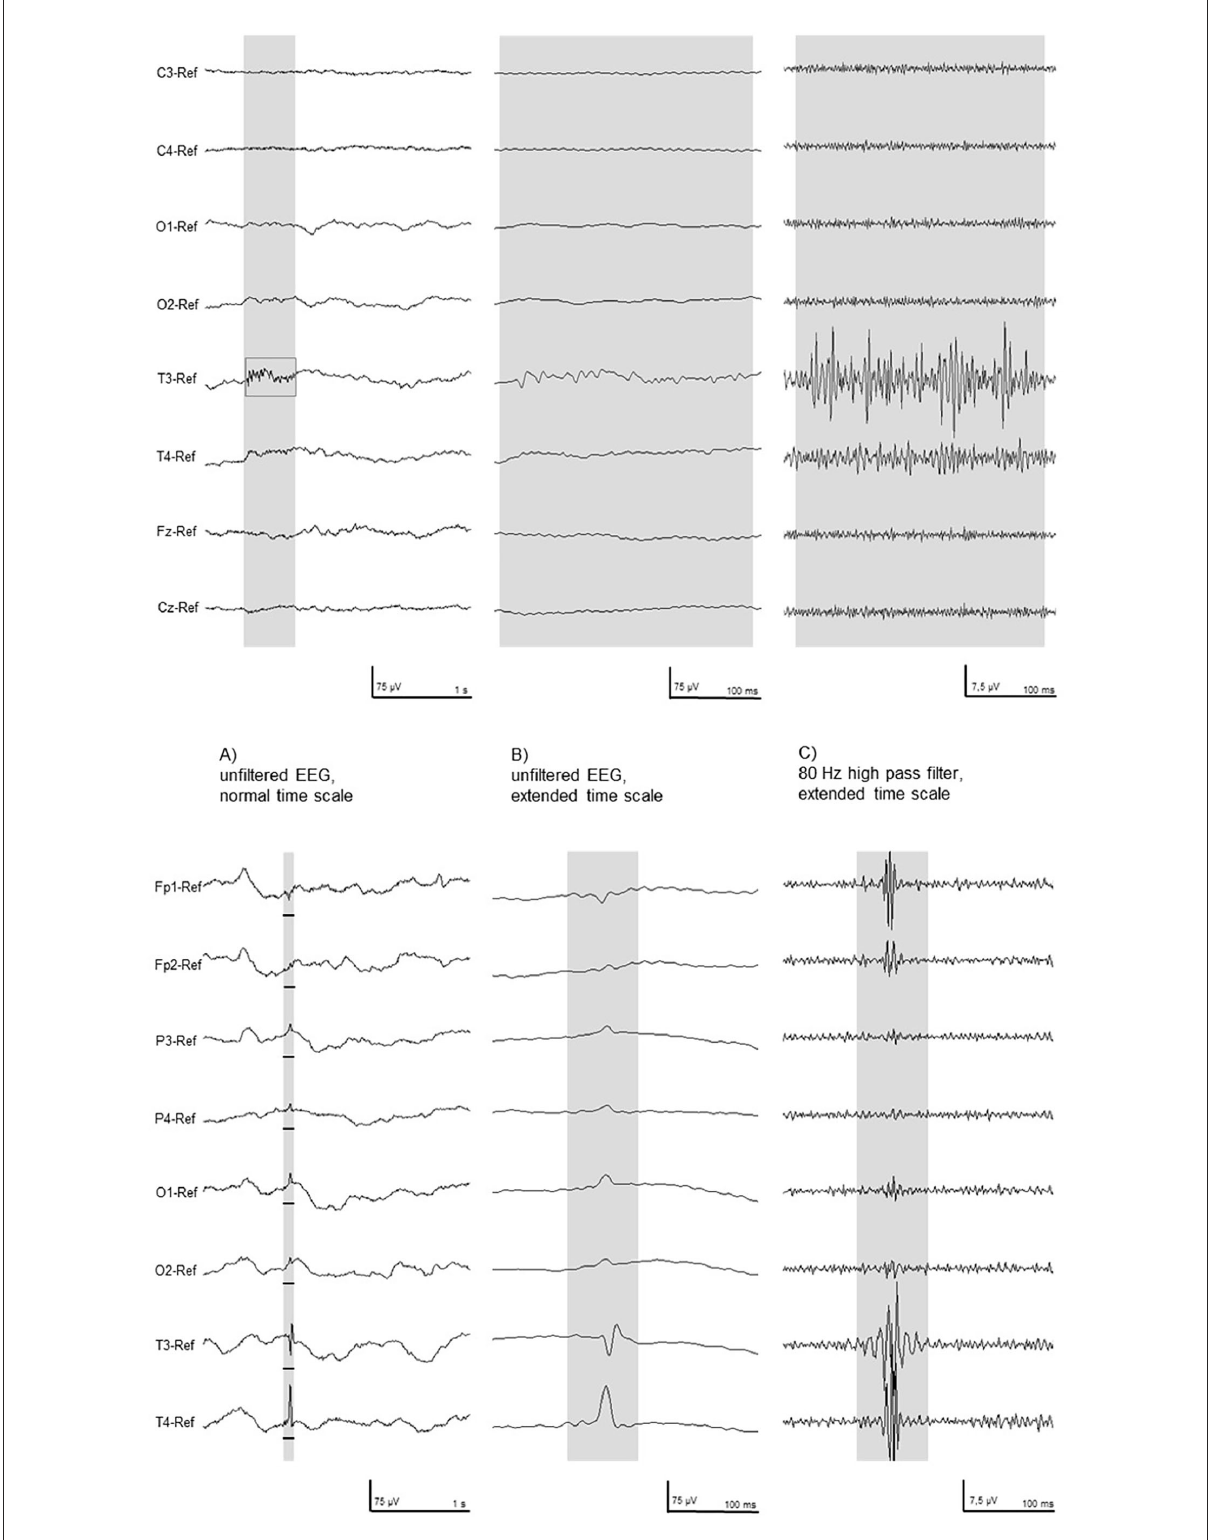
FIGURE2 Two typical examples of high-frequency activity in the filtered EEG (Right) were excluded as artifact, as seen in the unfiltered EEG (Left) . These EEG segments were recorded in patient #